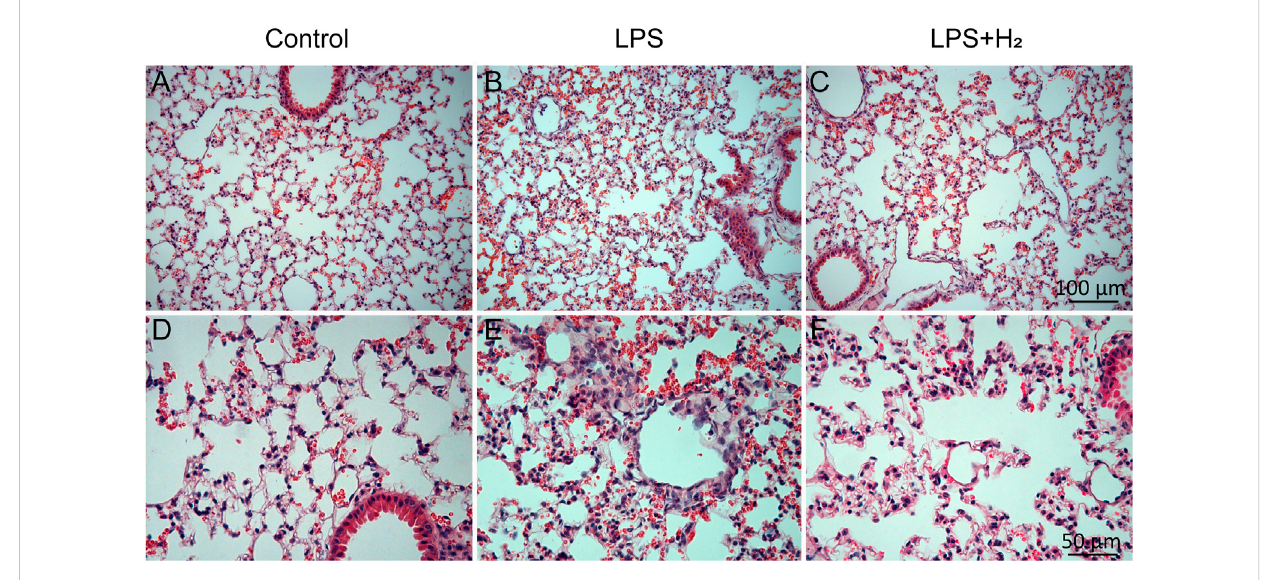
FIGURE 1 Pathologicalchangesinmouselungtissue.ThreehoursaftertheLPS(2 mg/kg)treatment,obviousin fl ammatoryexudationandleukocyteadhesion and aggregation wereobserved inthelung tissues ofmice (B,E) . Hydrogen(42%)administrationfor 3 halleviated thepathological in fl ammatorychanges in the tissues (C,F) . (A – C) scale bar, 100 μ m; (D – F) scale bar, 50 μ